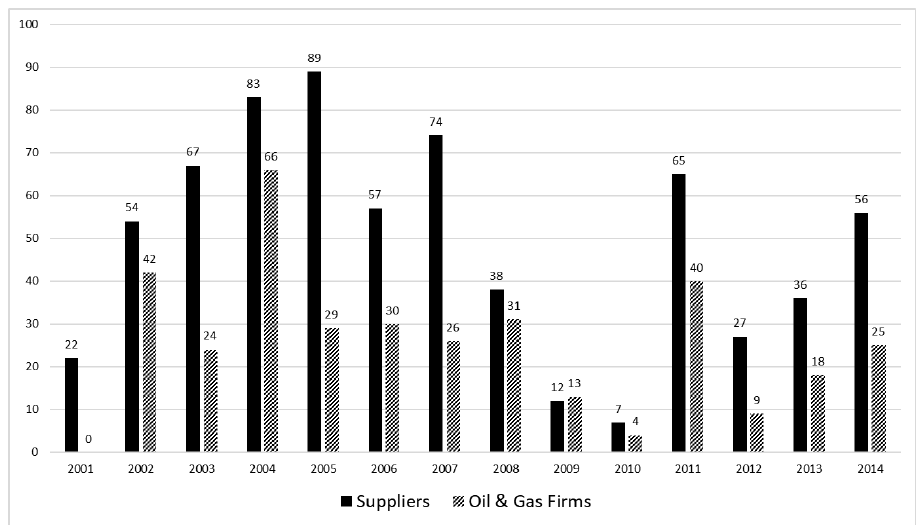
Fig. 1. Patents per year – Oil & Gas Operators and Suppliers